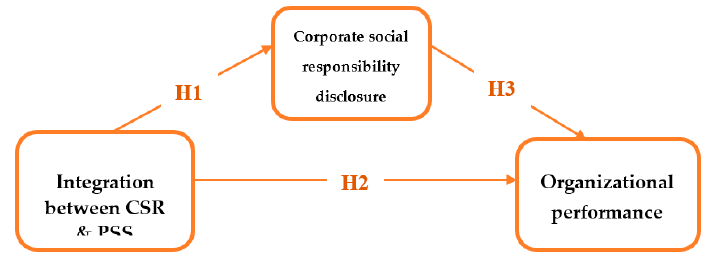
Figure 1. Proposed research model.